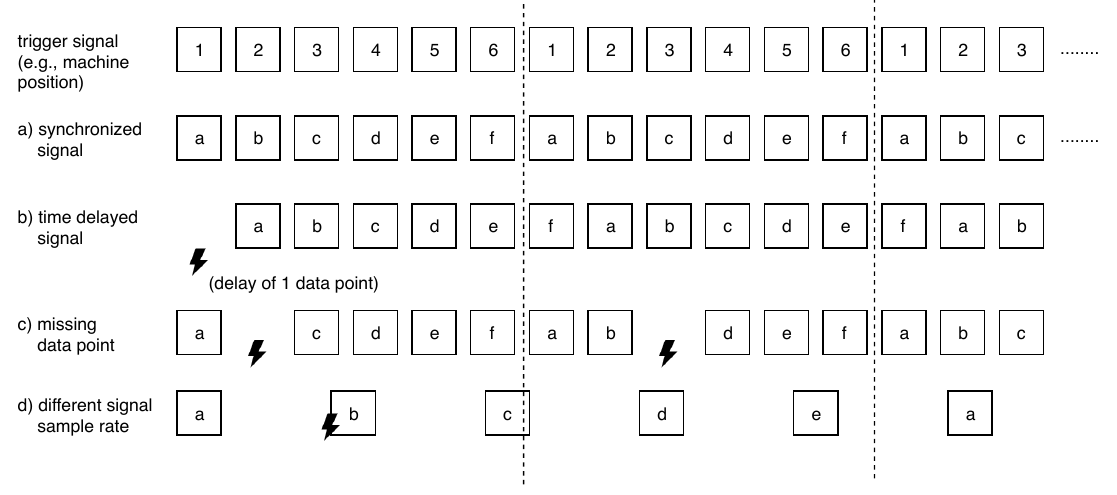
Figure 16. Data point